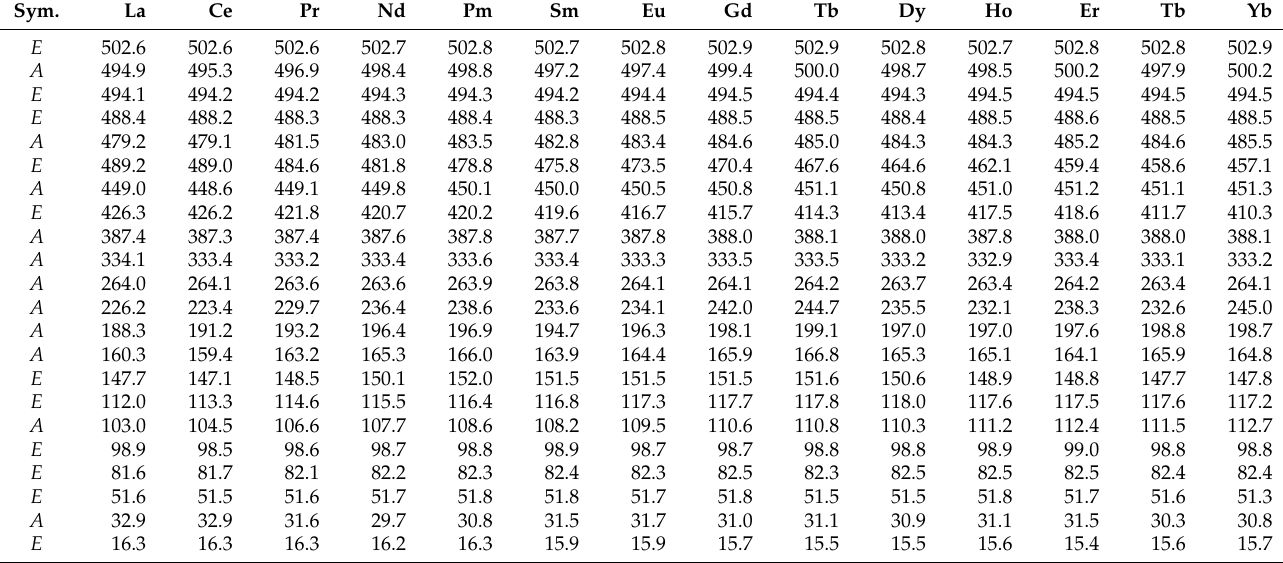
Table A1. Raman frequencies (in cm − 1 ) calculated for the silicide monolayer with (1 × 1) periodicity for different rare earths within DFT-PBEsol. Sym.